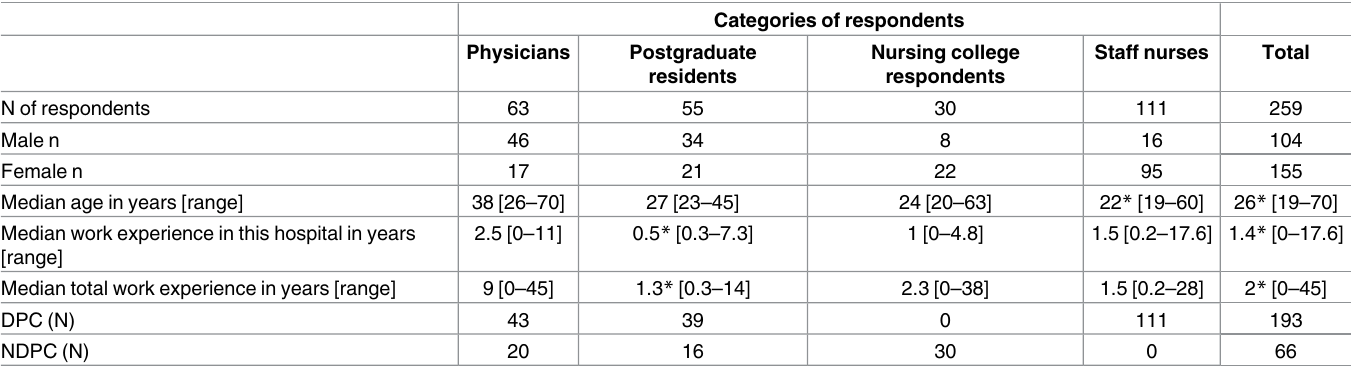
Table 1. Demographic characteristics of the study population in study